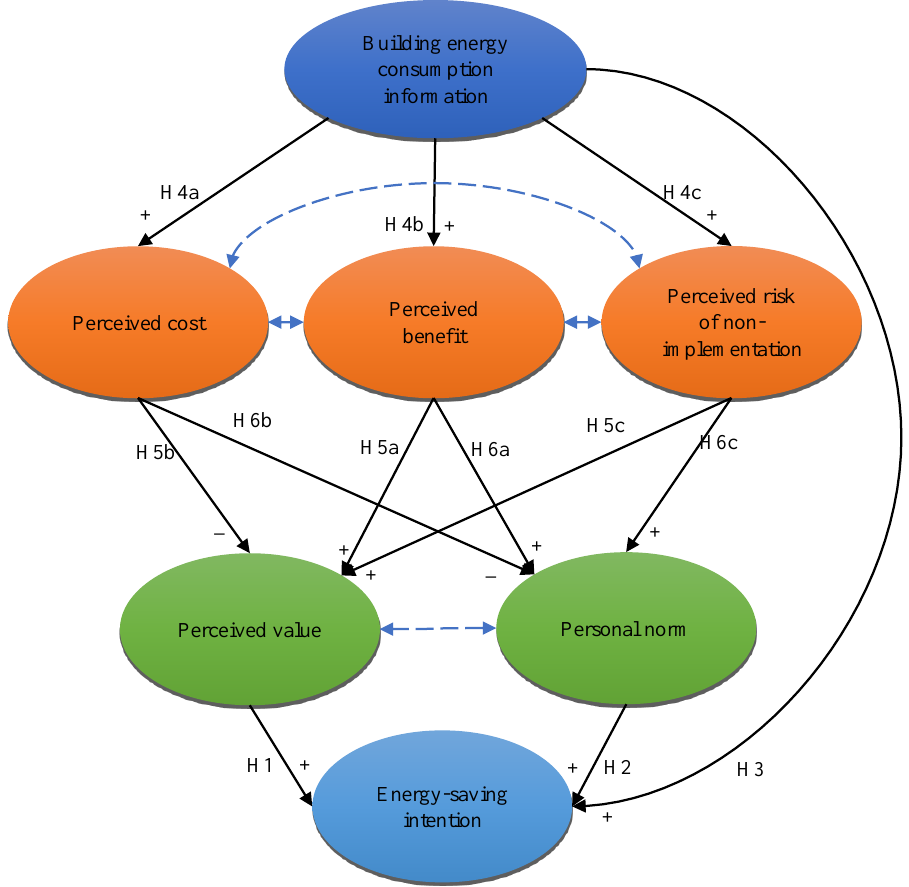
Figure 2. Structural model of the research.